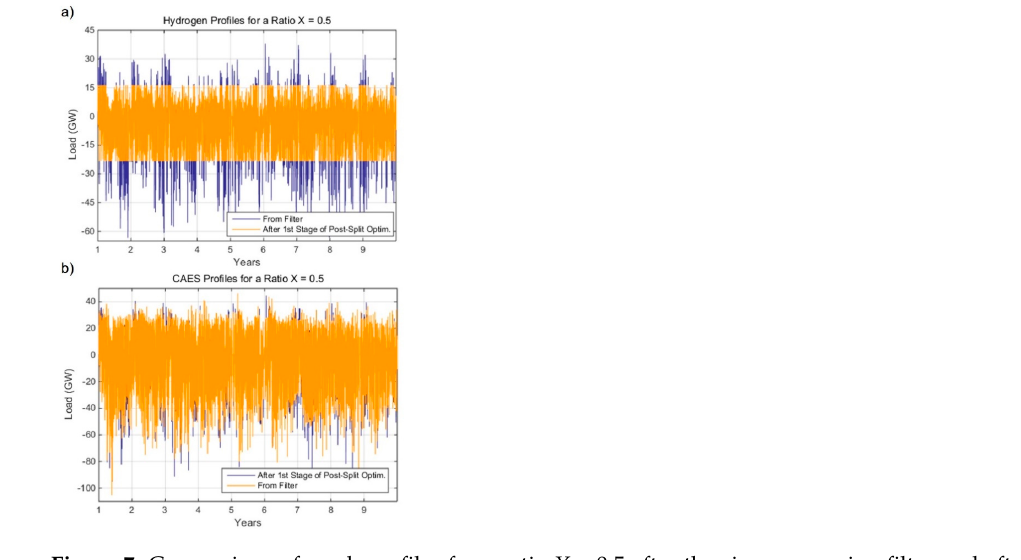
Figure 7. Comparison of work profiles for a ratio X = 0.5 after the sign-preserving filter and after post-split optimization. ( a ) Work profiles for hydrogen; ( b ) work profiles for CAES.